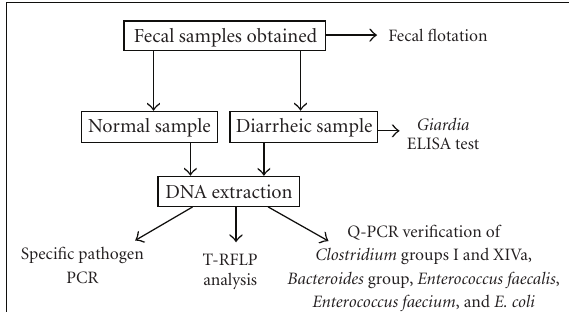
Figure 1: Scheme for sample